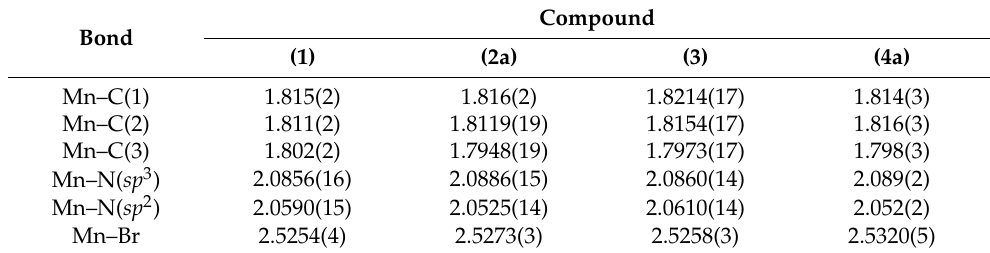
Table 1. Selected bond lengths (Å) for compounds ( 1 )–( 4 ). Bond